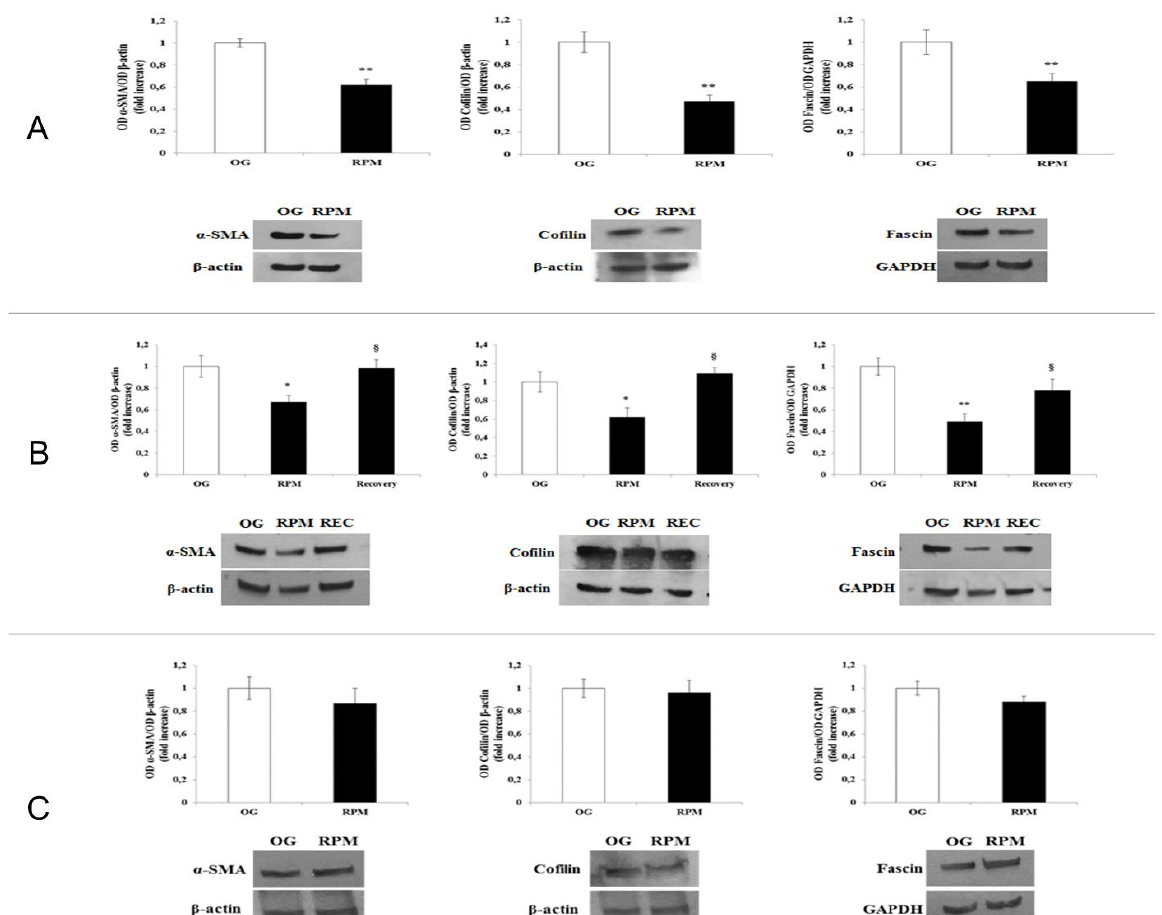
Figure 7. Western blot analyses of α -SMA, Cofilin, and Fascin in human dermal fibroblasts exposed to simulated microgravity (RPM). Columns represent densitometric quantification of the optical density (OD) of a specific protein signal normalized with the OD values of the β -actin ( α -SMA and Cofilin) and GAPHD (Fascin). Values are expressed as a fold increase of on-ground control (OG). Each column represents the mean value ± SD of three independent experiments, where SD is depicted as vertical bars. ( A ) Fibroblasts exposed to simulated weightlessness (RPM) and in normal gravity (OG) for 24 h. Each column represents the mean value ± SD of three independent experiments, where SD is depicted as vertical bars. ** p < 0.01 RPM versus OG by an unpaired two-tailed t -test. On the bottom, a panel of representative Western blot analyses is reported. ( B ) Same conditions as in A: cells are reseeded into normal gravity (recovery) for 24 h. ** p < 0.01 RPM versus OG; § p < 0.05 recovery versus RPM by ANOVA followed by Bonferroni post-test. ( C ). Western blot analyses of α -SMA, Cofilin and Fascin in human dermal fibroblasts exposed to simulated microgravity (RPM) for 72 h. Data were statistically analyzed with unpaired two-tailed t -test. No significant differences were recorded between on-ground and in-microgravity cultured cells after 72 h of µ G. On the bottom, a panel of representative Western blot analyses is